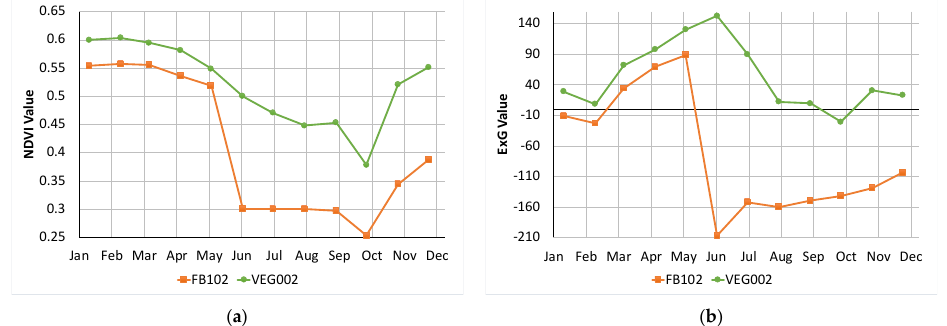
Figure 5. Spectral indices time-series comparison from FB and VEG areas in Serra dos Candeeiros during 2017. Phenology effects are present in both indices, but when an operation occurs, ExG is more robust than NDVI. ( a ) NDVI; ( b ) ExG.